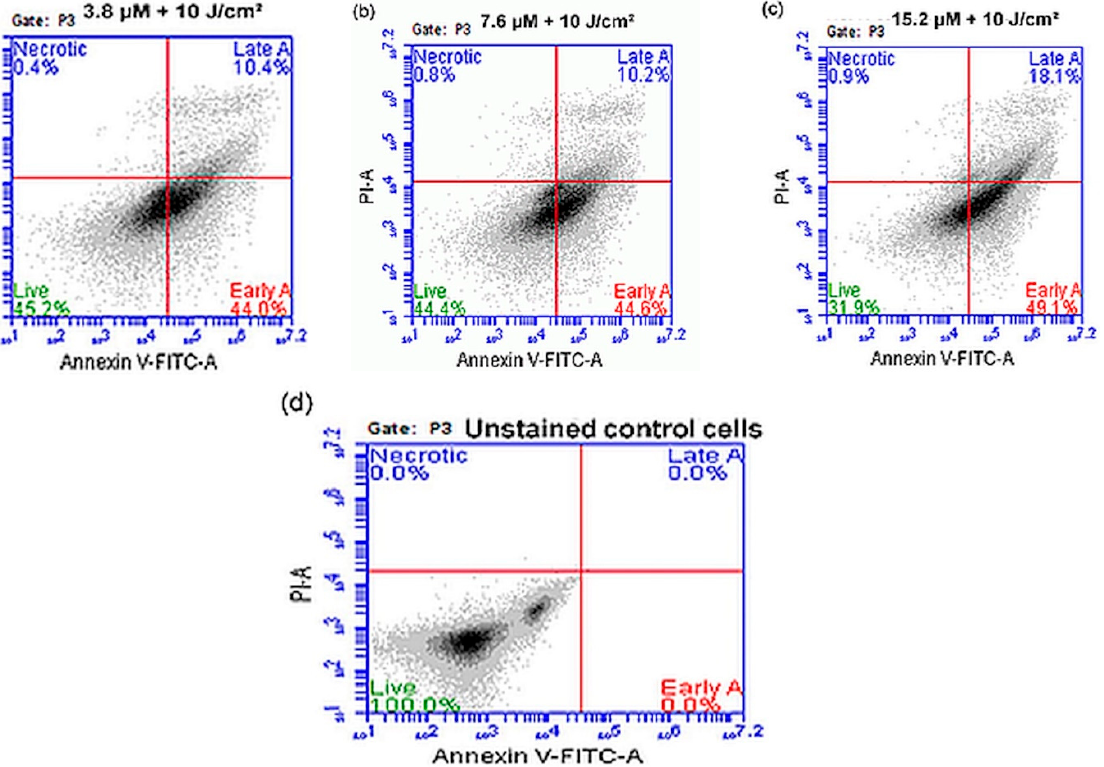
Figure 9. Annexin V/PI flow cytometry results demonstrating that cell death occurs mainly via early and late-stage apoptosis from the lowest to the highest 12 h post-PDT treatment at 10 J/cm 2 . ( a ) 3.8 µ M, ( b ) 7.6 µ M, and ( c ) 15.2 µ M. ( d ) Shows untreated control cells.